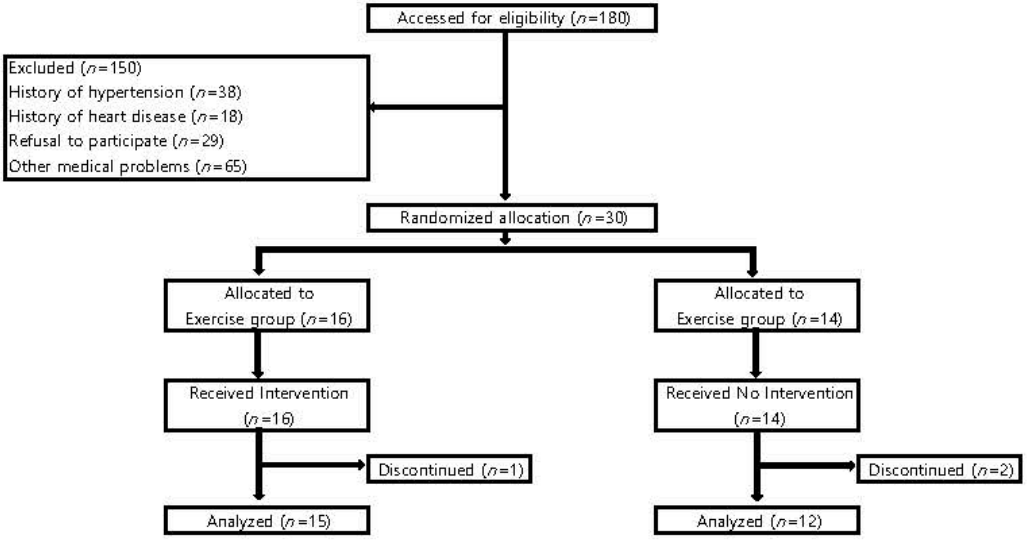
Figure 1. The flow of the randomized controlled study.